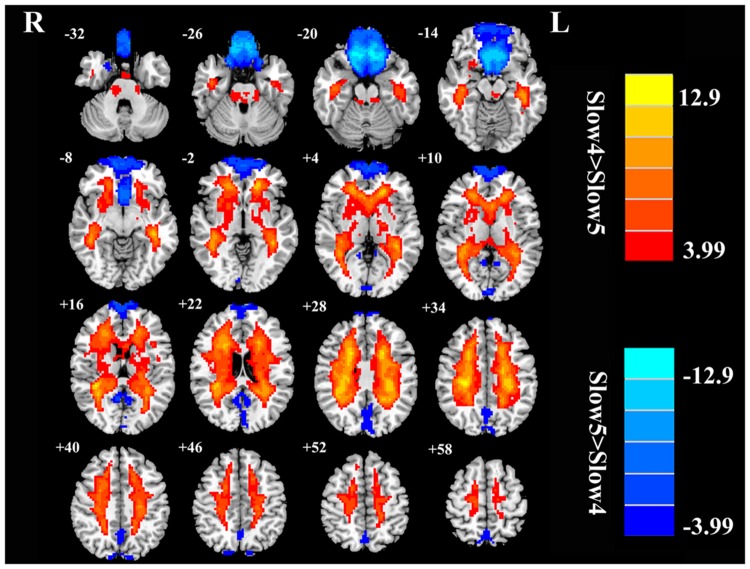
The main effects for frequency band on fALFF. Red/hot colors identify brain regions where slow-4 fALFF values were significantly greater than slow-5 fALFF values (t-values 3.99 to 12.9; red to yellow, respectively). Blue/cold colors identify brain regions where slow-5 fALFF values were significantly greater than slow-4 fALFF values (t-values –3.99 to –12.9; dark blue to light blue, respectively). Results were obtained by a two-way repeated-measure ANOVA. AlphaSim corrected p < 0.05 (individual voxel thresholds p < 0.05 with a minimum cluster size of 3591 mm3).